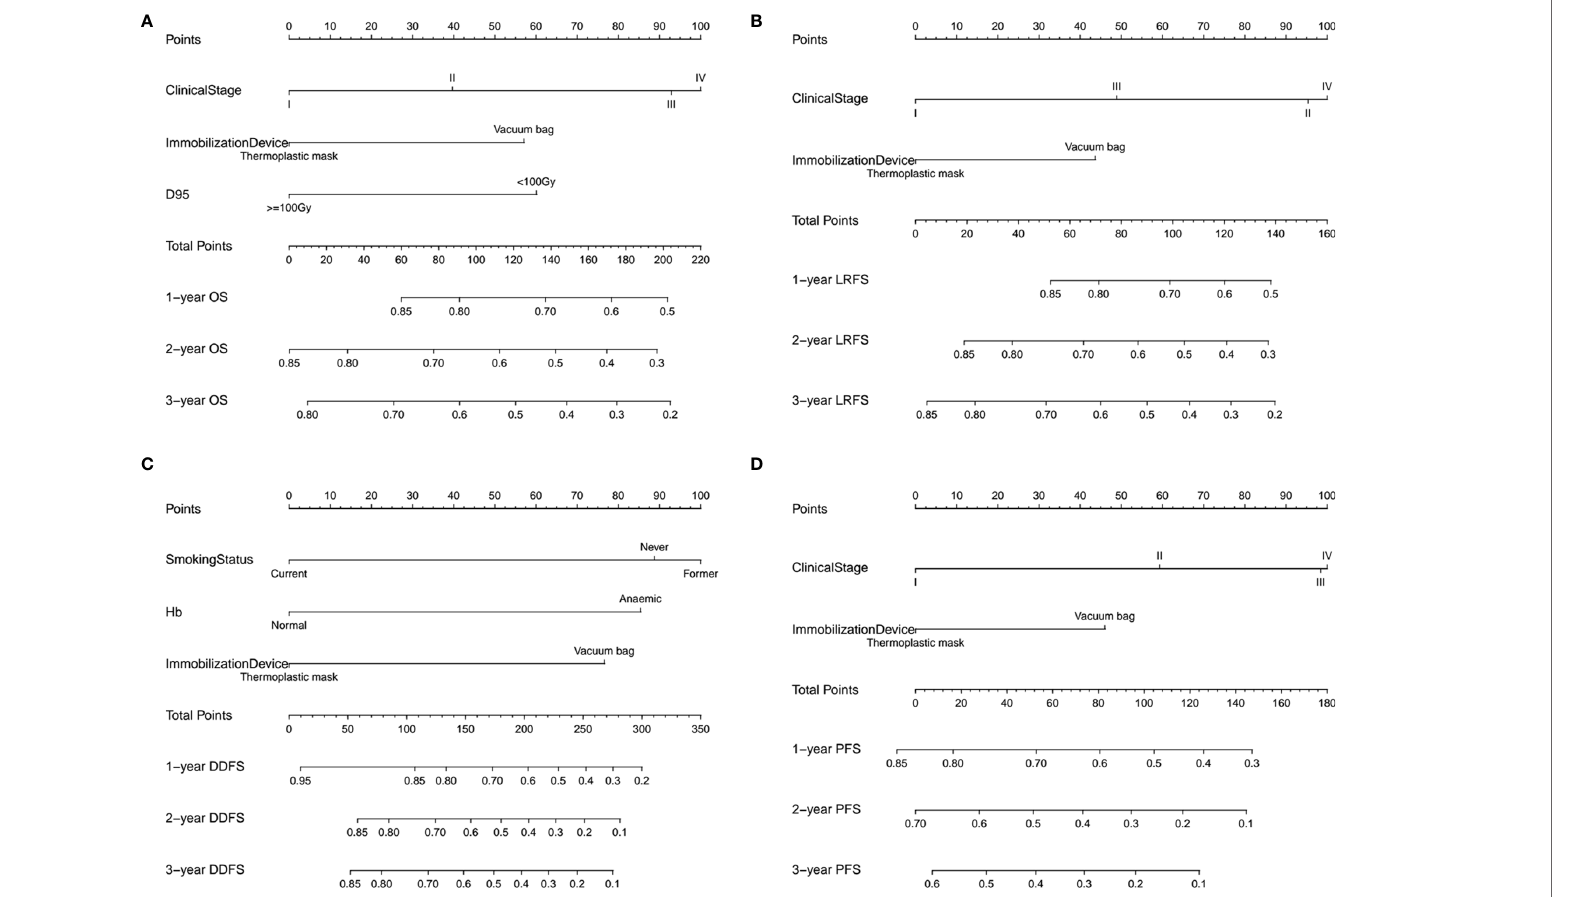
FIGURE 6 | The nomogram containing identi fi ed factors for the 1-, 2-, and 3-year OS, LRFS, DDFS and PFS prediction of lung cancer patients. (A) Nomogram for OS, (B) nomogram for LRFS, (C) nomogram for DDFS and (D) nomogram for PFS. D95, the prescription dose covers 95% of the target area; OS, overall survival; LRFS, local recurrence free survival; DDFS, distant disease-free survival; PFS, progression free